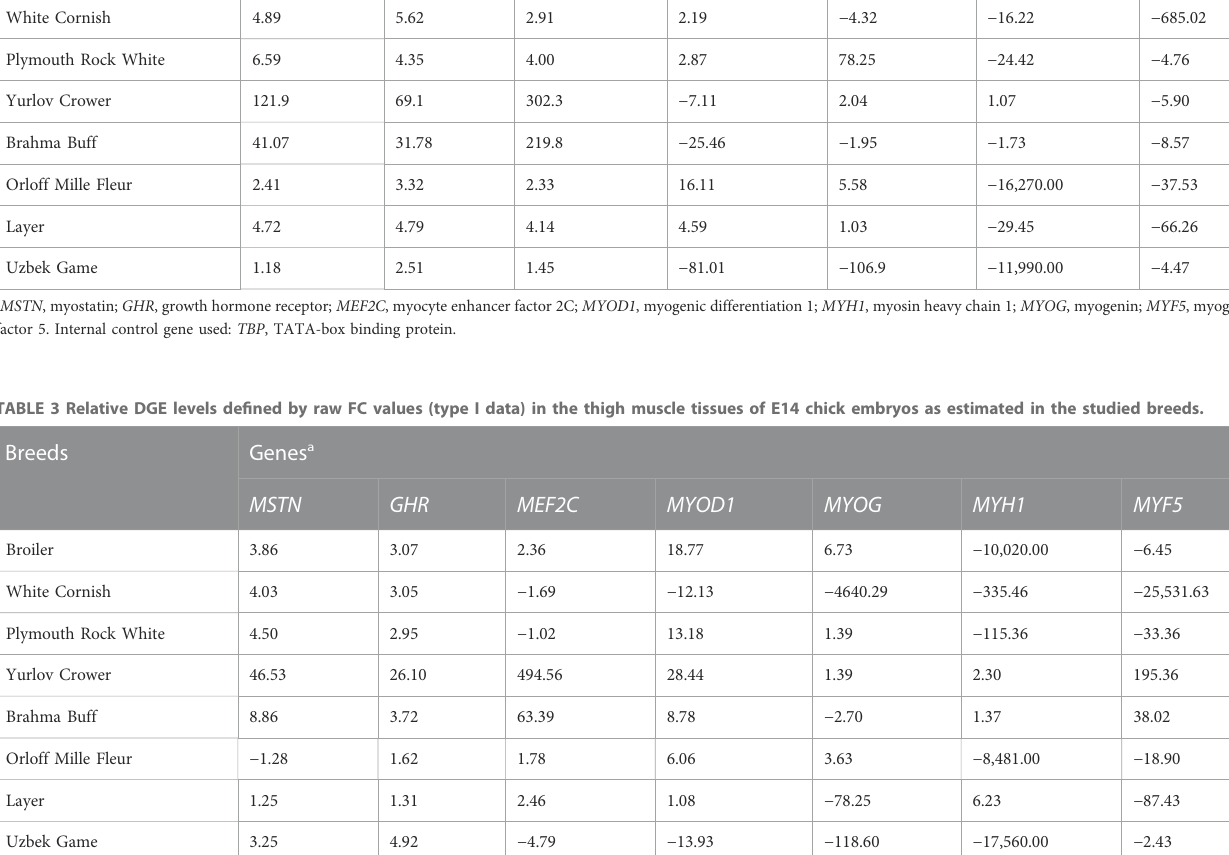
TABLE 2 Relative DGE levels de fi ned by raw FC values (type I data) in the breast muscle tissues of E14 chick embryos as estimated in the studied breeds. Breeds Genes a MSTN